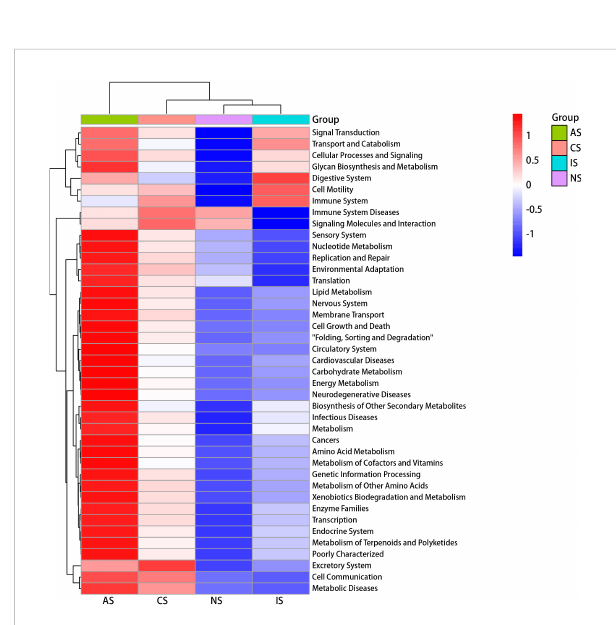
FIGURE 6 Heat map of KEGG function prediction of the four groups. Red indicates a higher relative abundance of species and blue indicates a lower relative abundance.